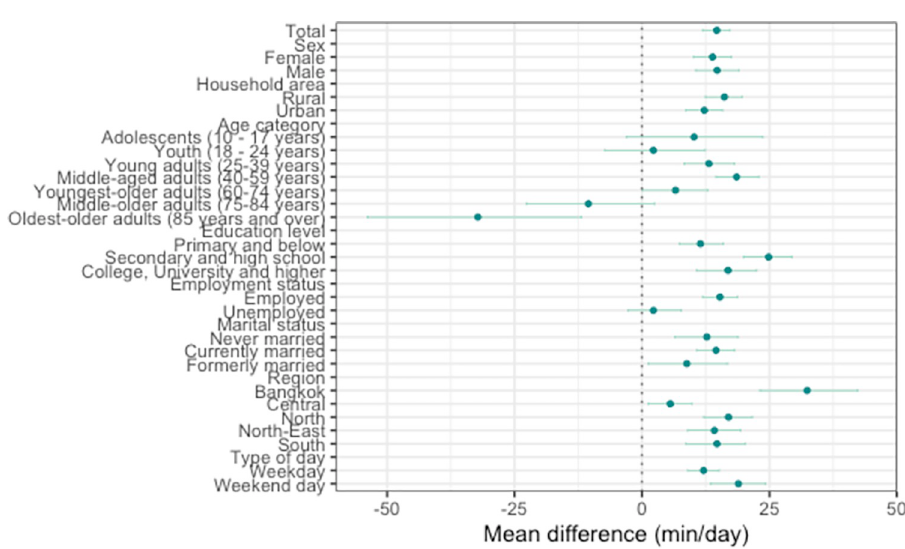
Fig 4. Mean difference in sleep duration from 2009 to 2015. Mean changes in sleep duration from 2009 to 2015 (circles) and their 95% bootstrap confidence intervals (whiskers).